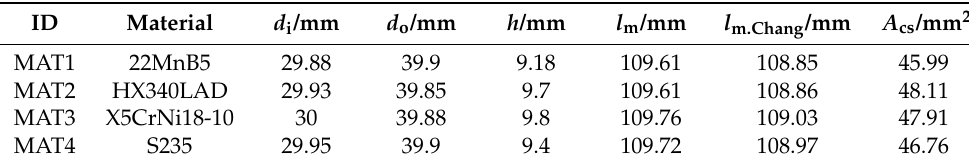
Table 2. Geometries of the toroidal ring